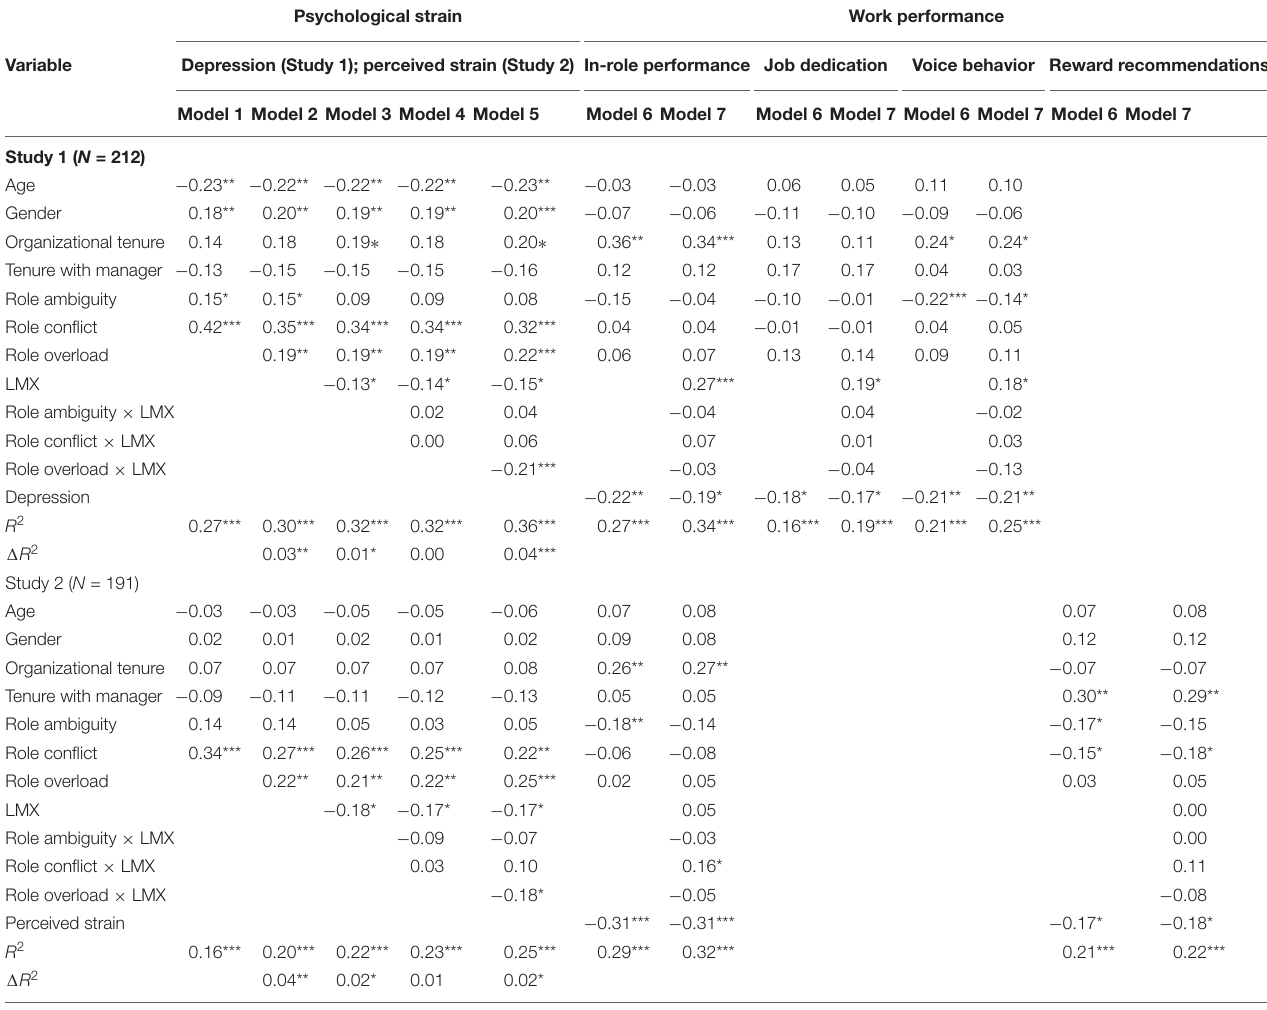
TABLE 3 | Study 1 and Study 2 Moderated Multiple Regression Analysis Results for Psychological Strain and Work Performance. Psychological strain Work